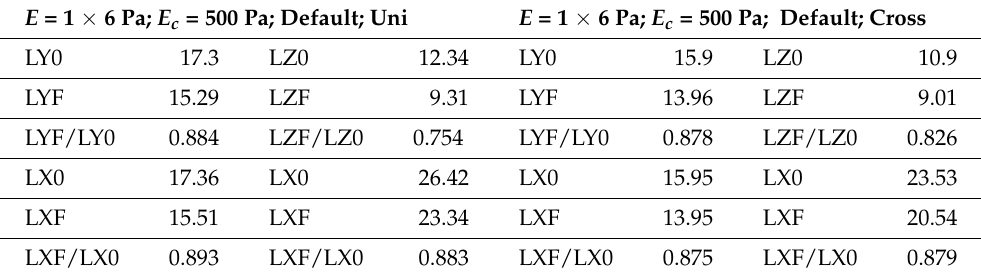
Table 3. Results of simulations of shrinkage of the submodel of the NIST artefact with the following